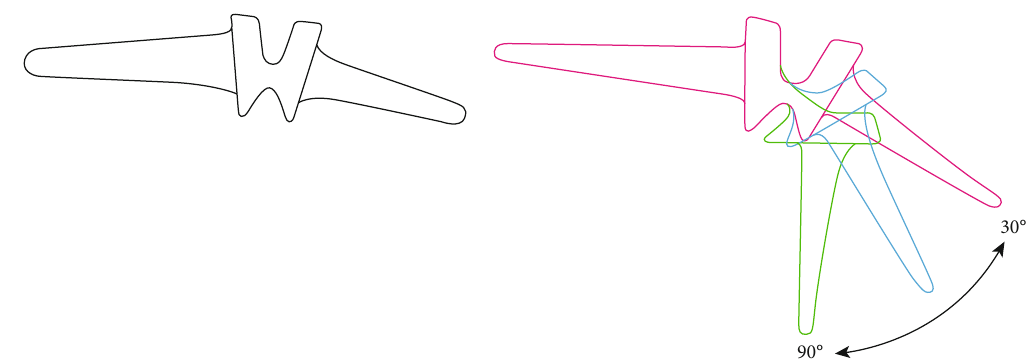
Figure 4: NeuFlex silicone fi nger joint with the di ff erent motion angles.